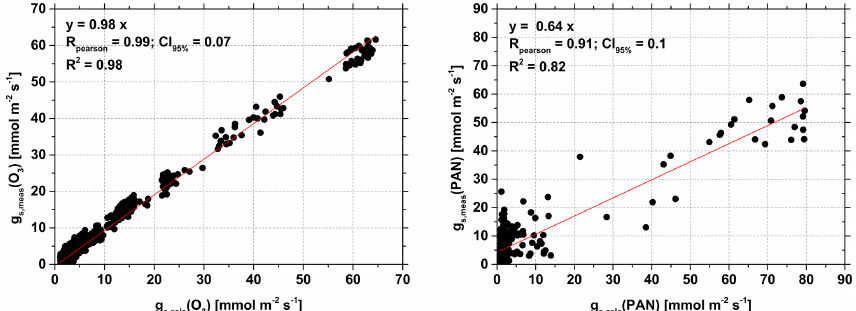
Figure 13. Relationship between the measured stomatal conductance g s,meas and calculated stomatal conductance g s,calc to O 3 (left) and PAN (right).